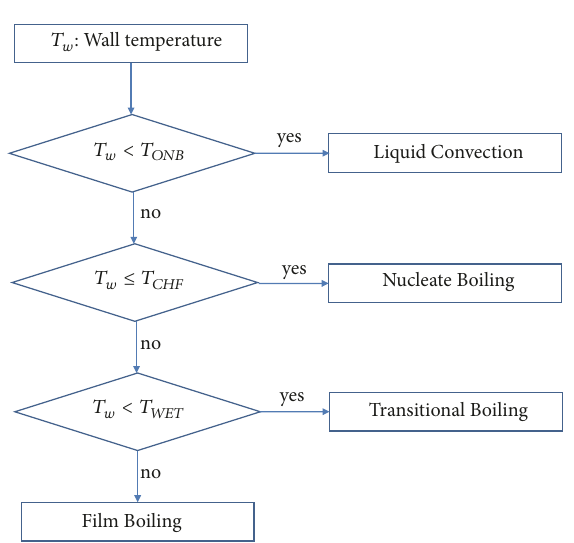
Figure 5: Schematic diagram of boiling heat flux